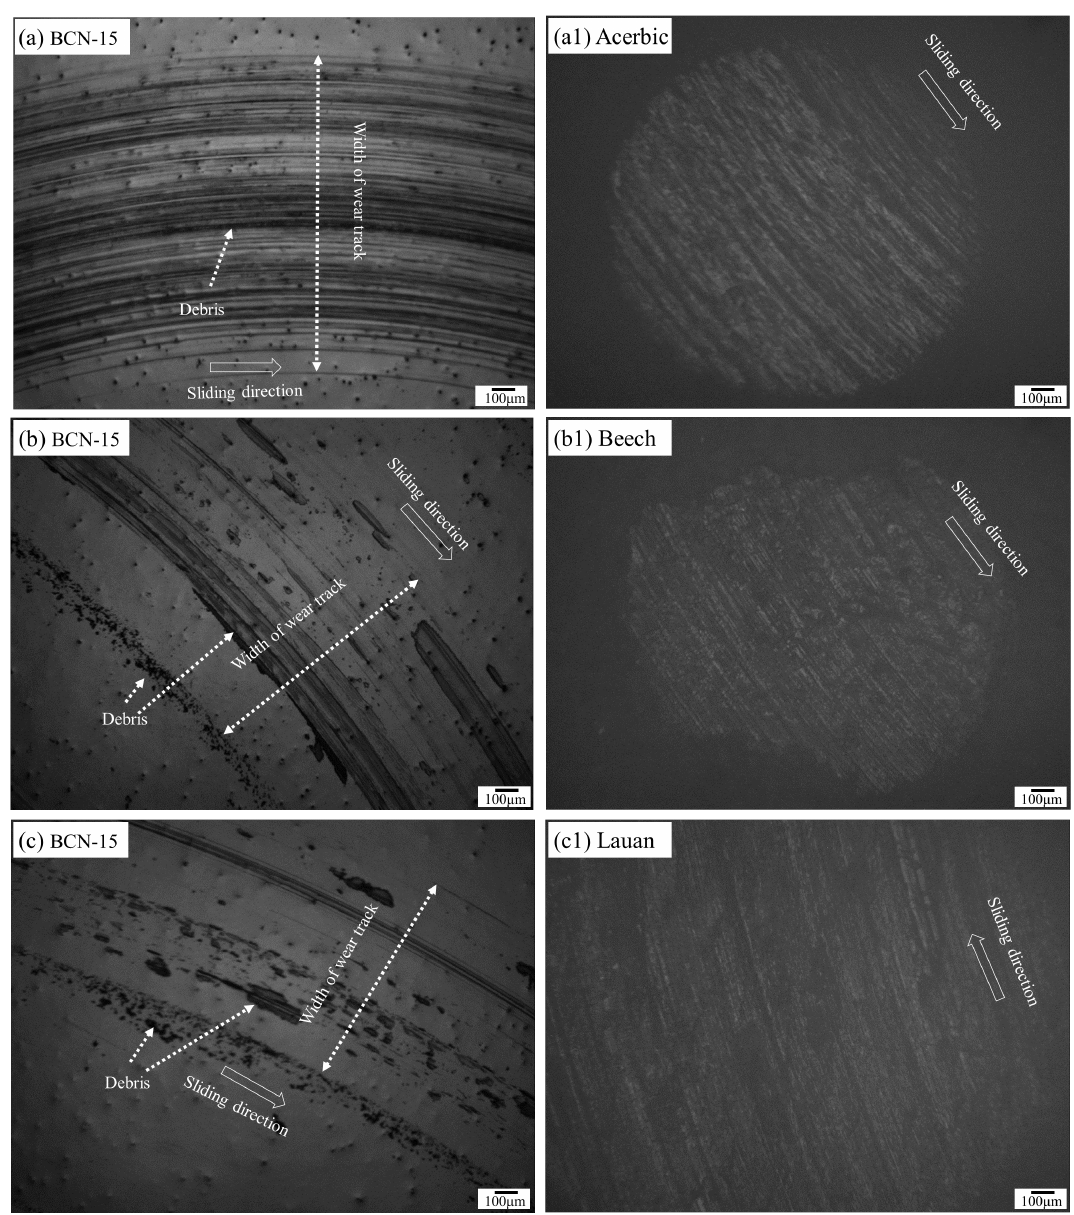
Figure 8: Optical images of wear scars for BCN-15 coating sliding against different wood balls.